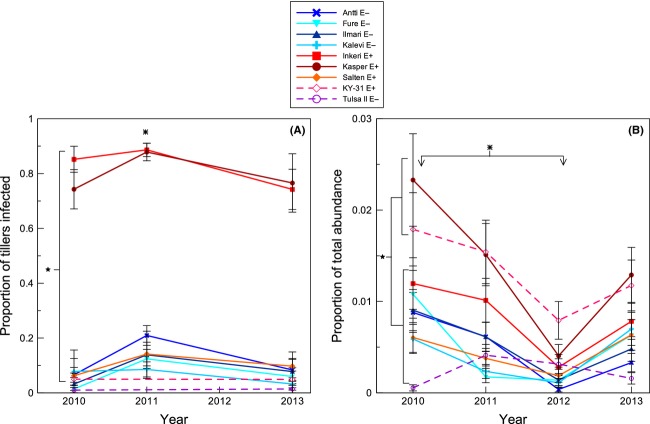
Proportion of Schedonorus pratensis (solid lines) and S. arundinaceus (broken lines) tillers that tested positive for endophyte presence (A) and Schedonorus relative abundance over time (B) in an old-field community. Means and standard errors are back transformed from generalized linear mixed models using inverse link functions and the delta method. S. arundinaceus cultivars were not tested for endophyte presence in 2011; no cultivars were tested in 2012. Stars and asterisks indicate significant differences between cultivars and years, respectively (post hoc Tukey tests, P < 0.05).